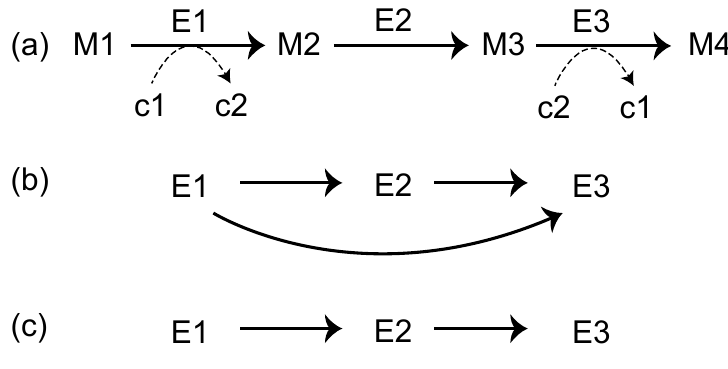
Figure 2. ( a ) A general representation of the metabolic pathway. Reactions are represented as enzymes (E1, E2, and E3). M1, M2, and M3 correspond to metabolic compounds. c1, c2, and c3 indicate currency metabolites such as ATP and NADH. The reaction network obtained from (a), without ( b ), and with ( c ) ubiquitous